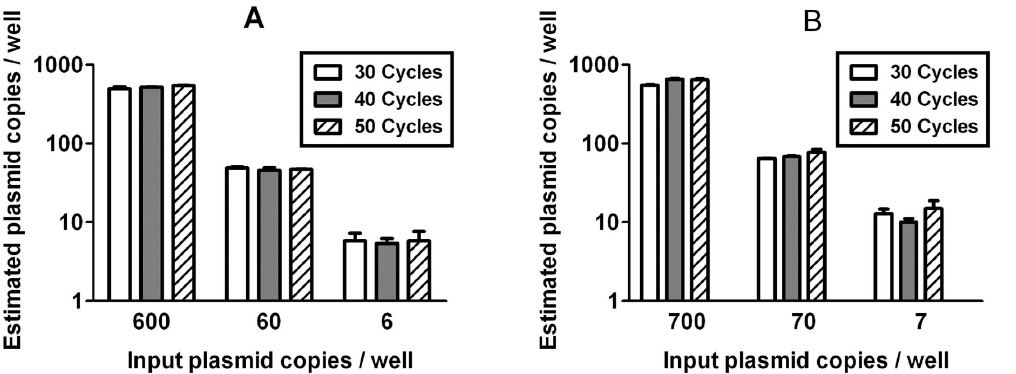
Figure 2. Values measured by digital PCR do not vary with cycle number. Plasmid templates were emulsified into droplets and thermally cycled for 30 to 50 cycles before analysis. No significant differences in measured pol ( A ) or 2-LTR ( B ) copy numbers were observed over this range of cycling times. No positive events were observed after 20 cycles (not shown). Similar results were obtained using dilutions of infected CD4 + T cells into uninfected PBMC (Fig. S.1). Error bars indicate the observed standard deviation between wells. doi:10.1371/journal.pone.0055943.g002 (Fig. 5). This allowed detection of both pol and 2-LTR circles at frequencies of 0.7 copies per 10 6 cells.